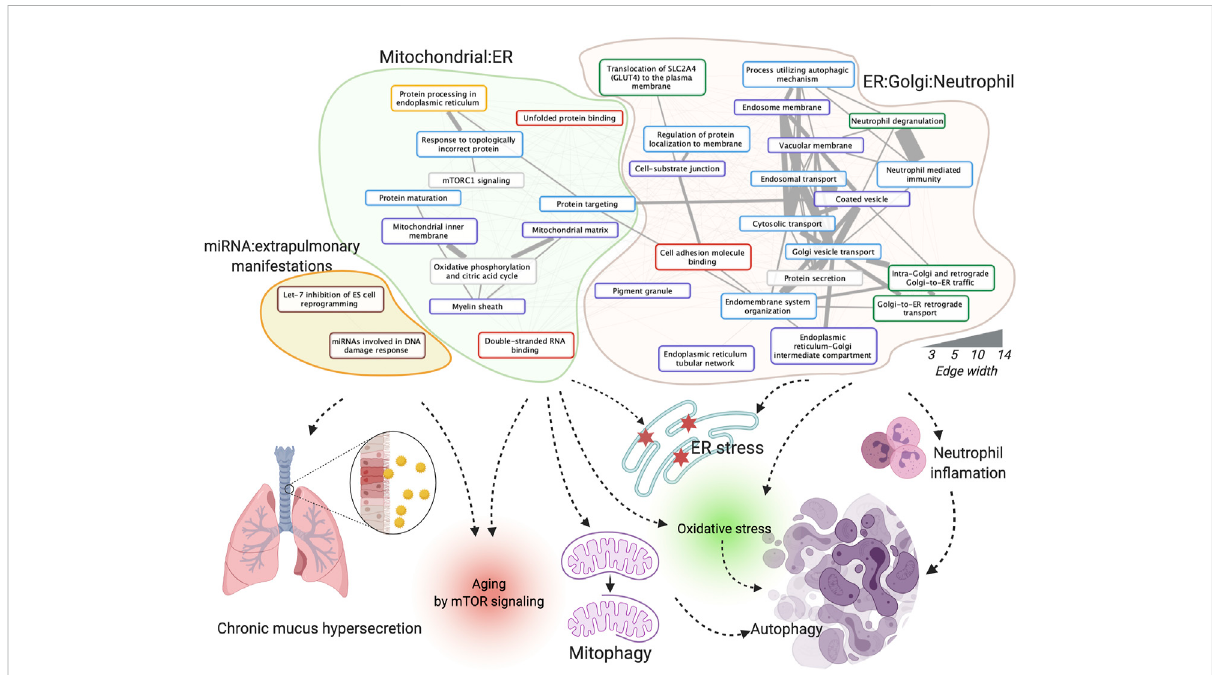
FIGURE 3 Enriched functions, function clusters, and their potential roles in COPD. The board colors of function terms are Hallmark50 (grey), Gene Ontology (GO) biological process (blue), GO cellular component (purple), GO molecular function (red), KEGG pathway (yellow), Reactome pathway (green), andWikiPathway(brown). The widthoftheedgescorrespondstothenumberofco-annotatedgenes. Createdusing igraph,Cytoscape, and